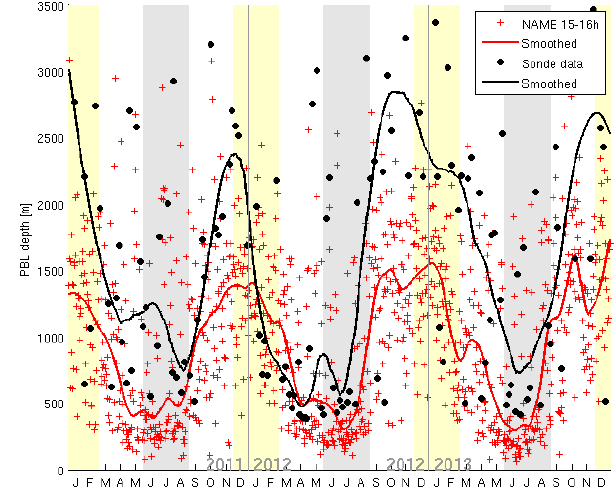
Figure 13. Comparison of boundary layer depth at LAU in NAME at 15:00–16:00LT and radiosonde observations made at the site (Heffter method). The seasonal cycle has been made more visual using a robust Loess smoother. Summer periods are highlighted in yellow, winter periods in grey.